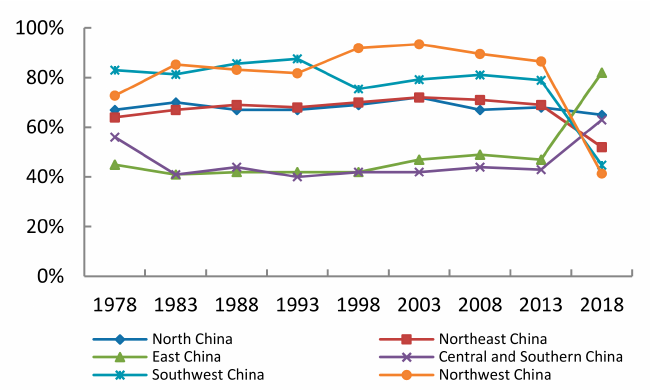
Figure 2. Changes in the contribution of sensitivity